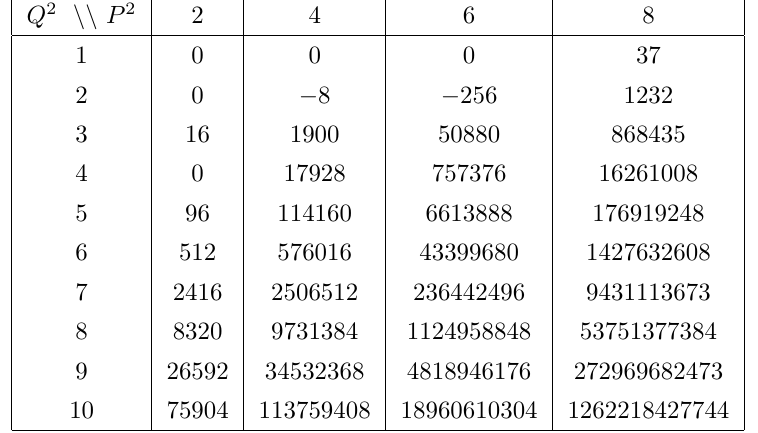
Table 23 . Index of horizon states for the Z 2 orbifold of T 6 when Q · P = 4 . Note that only when Q 2 P 2 − ( Q · P ) 2 < 0 we observe that the index is